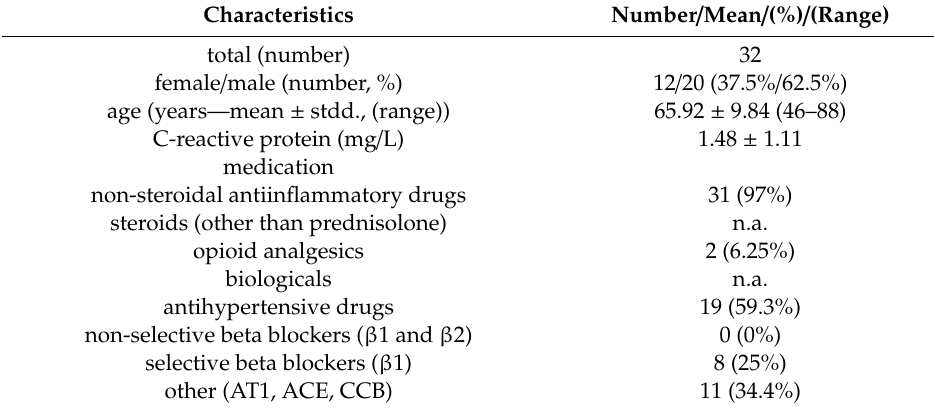
Table 1. Characteristics and medication of patients under